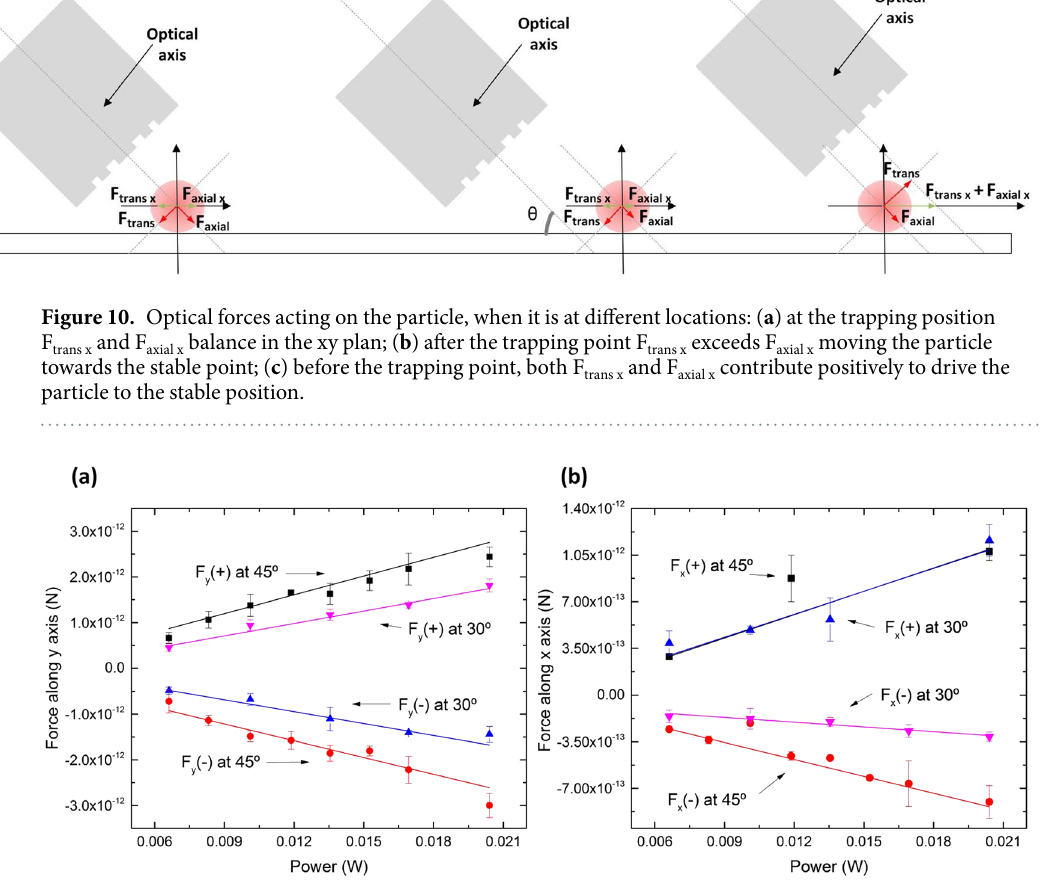
Figure 11. ( a ) Force along the y axis, measured with the optical fibre positioned at 45° and 30°; ( b ) Force along the x axis, measured with the optical fibre positioned at 45° and 30°.